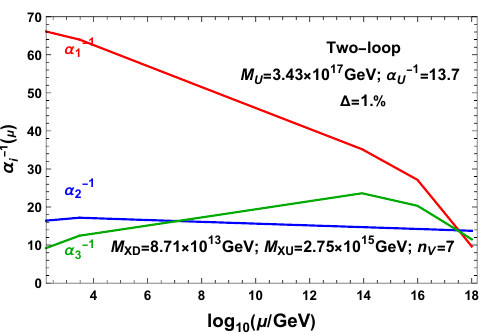
= 10 × 5 and k = 2 . The string-scale gauge coupling relation Y 2 13 3